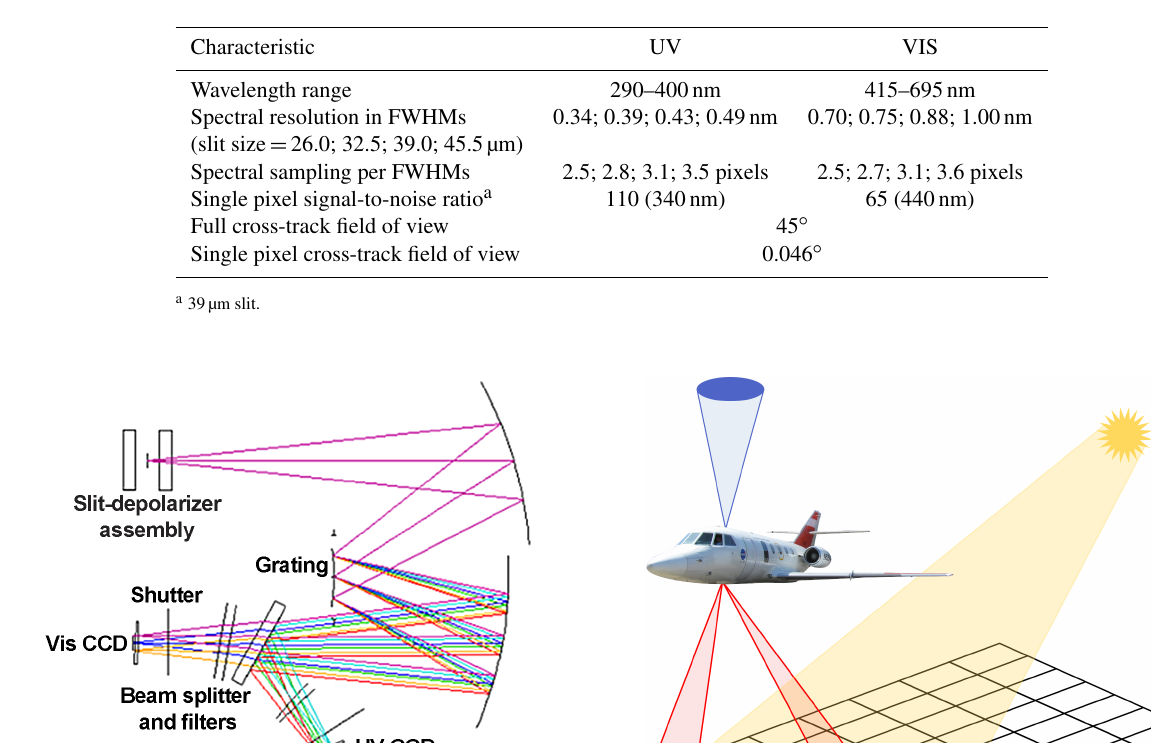
Table 1. GeoTASO instrument characteristics. Four different slit sizes can be used in a slit holder assembly to give different spectral resolu- tions and spectral sampling values.